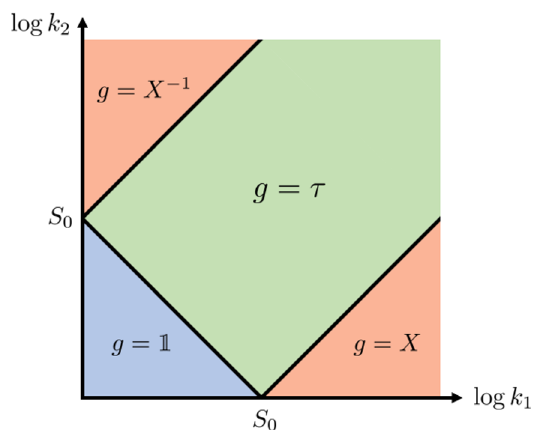
Figure 4 . The phase diagram for entanglement negativity. The four phases are labeled by the permutations corresponding to their dominant